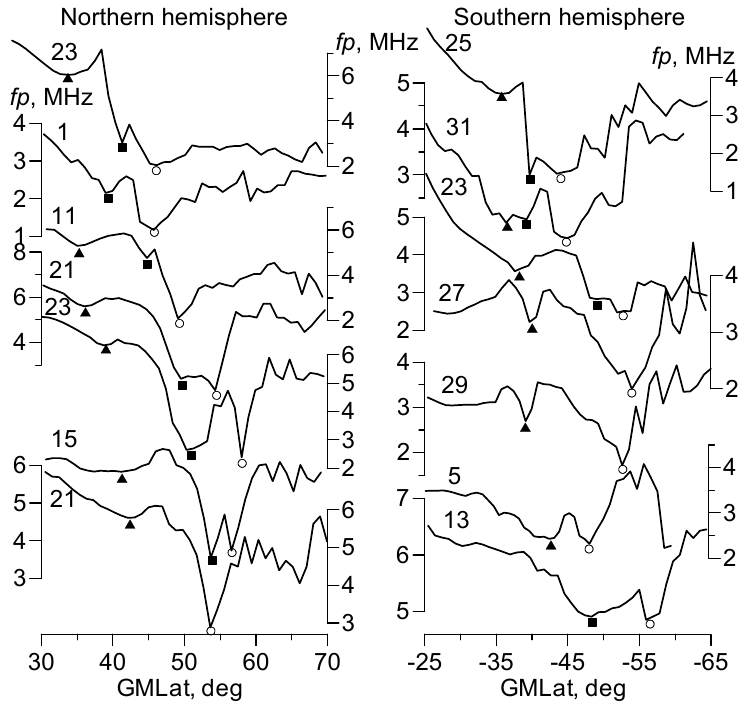
Figure 2. Latitudinal fp profiles in the Northern and Southern hemispheres for the CHAMP passes indicated in Figure 1. The minimum of each trough is marked by corresponding symbol.